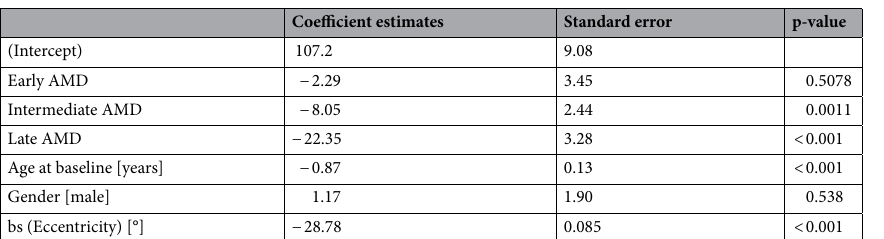
Table 2. Results of multivariable linear mixed-model analysis of the impact of AMD severity stage compared to control on the rEZR as presented with coefficient estimates, standard error and p-value, respectively. Eccentricity is included in the model as a b-spline of degree 2. AMD age-related macular